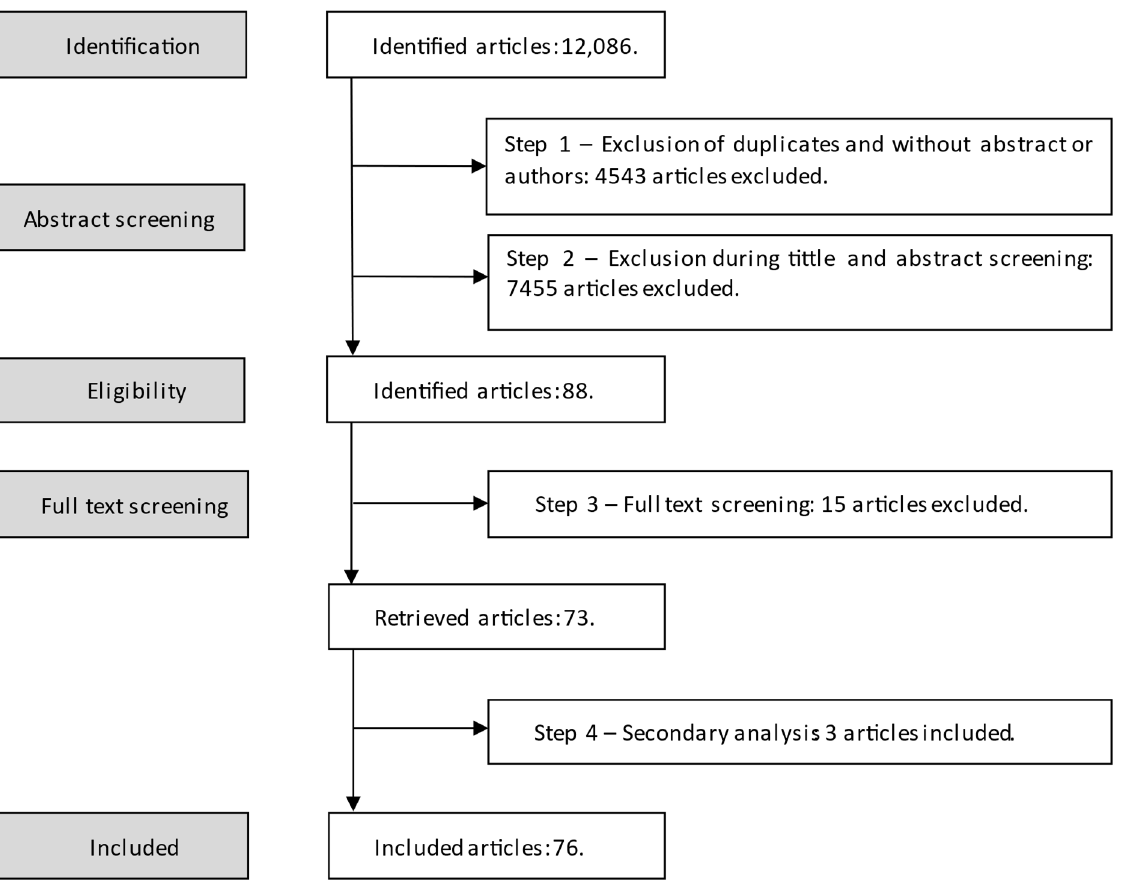
Figure 1. PRISMA flowchart of the systematic review.